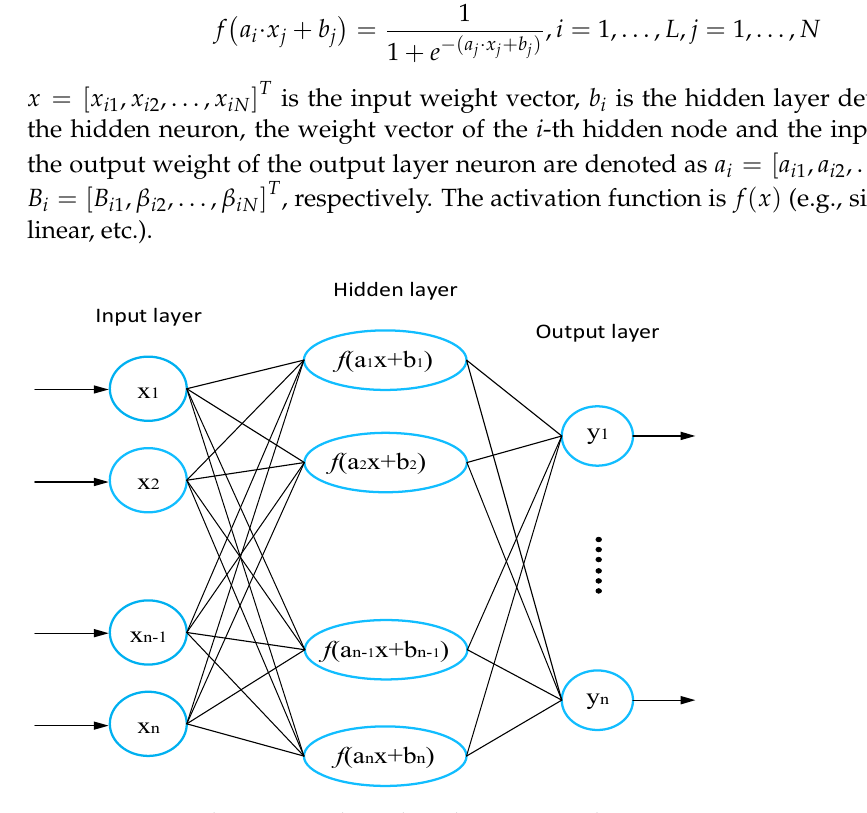
Figure 4. Extreme learning machine algorithm structure diagram.